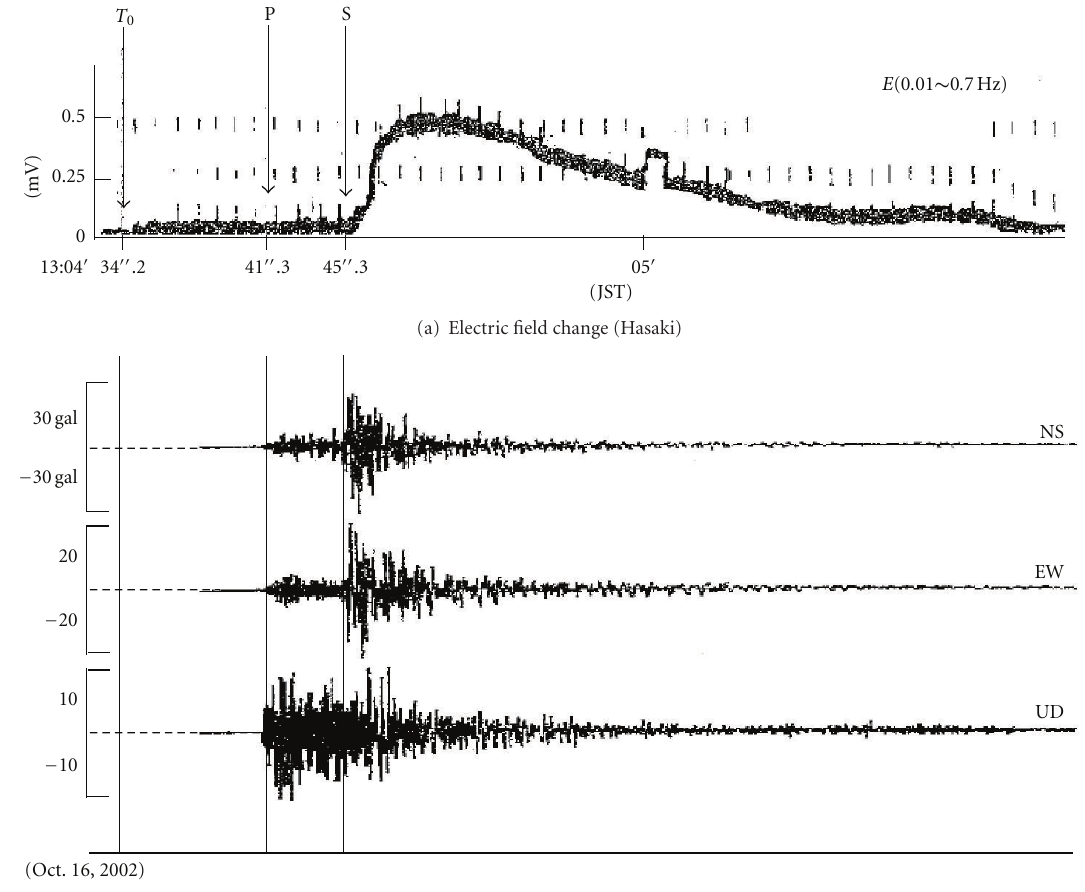
Figure 4: High-speed monitoring record of electric field variation at Hasaki inducing considerably similar electric field changes starting from the origin time of the earthquake on October 16, 2002 (E2 in Figure 1), like the case shown in Figure 2. Vertical bars are the origin time, P wave arrival, and S wave arrival of the strong motion seismogram, respectively. The two cases have common features: there is an initial increase of strength of the electric field approximately coinciding with the earthquake origin time, and the largest variation after the S wave arrival lasts for several tens of seconds. In both cases there was no peak at the time of P wave